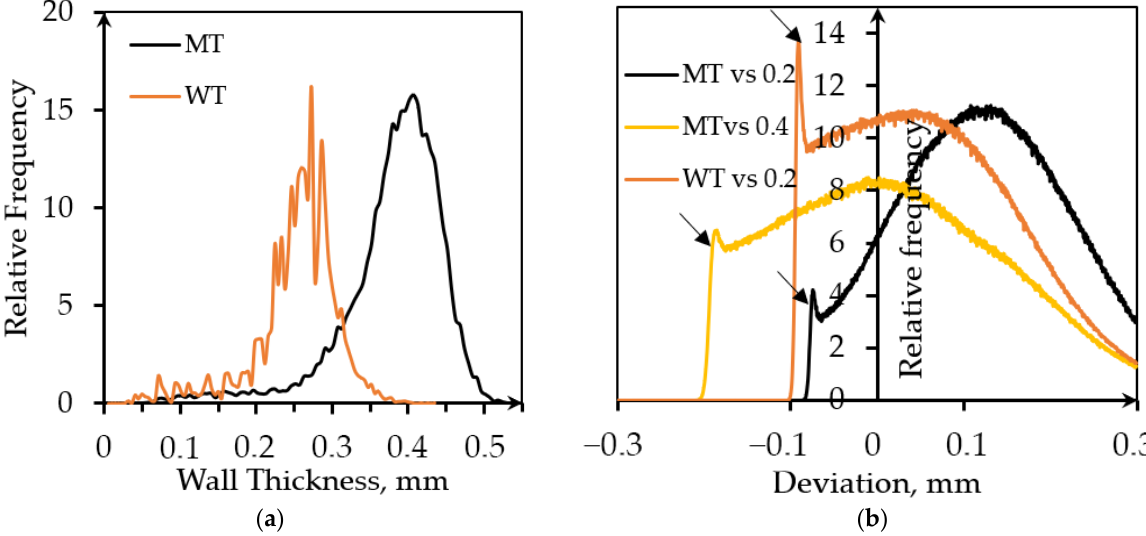
Figure 3. Evaluation of the parameters based on the XCT data analysis: ( a ) Wall thickness distribution; ( b ) Deviation distribution obtained from Nominal/Actual Comparison analysis. Table 2. Summary of the results of the quantitative image analysis of XCT data. (Measurement er- rors cannot be estimated; the error intervals represent the variance of all the measured values).